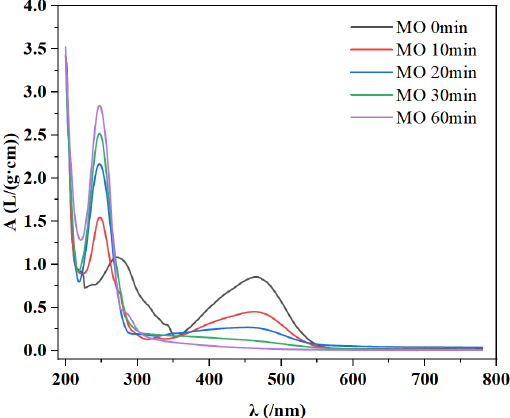
Figure 9. Absorbance spectra of MO solution over the reaction time.